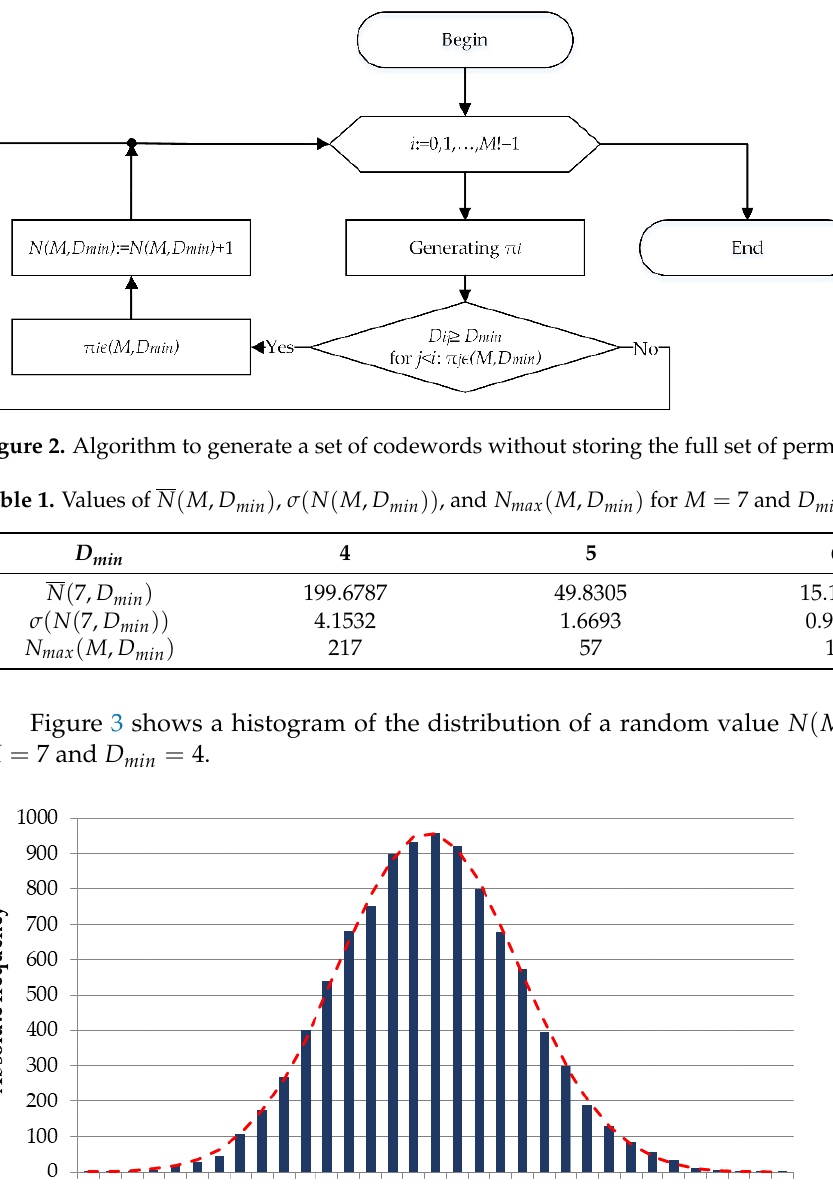
Figure 2. Algorithm to generate a set of codewords without storing the full set of permutations.